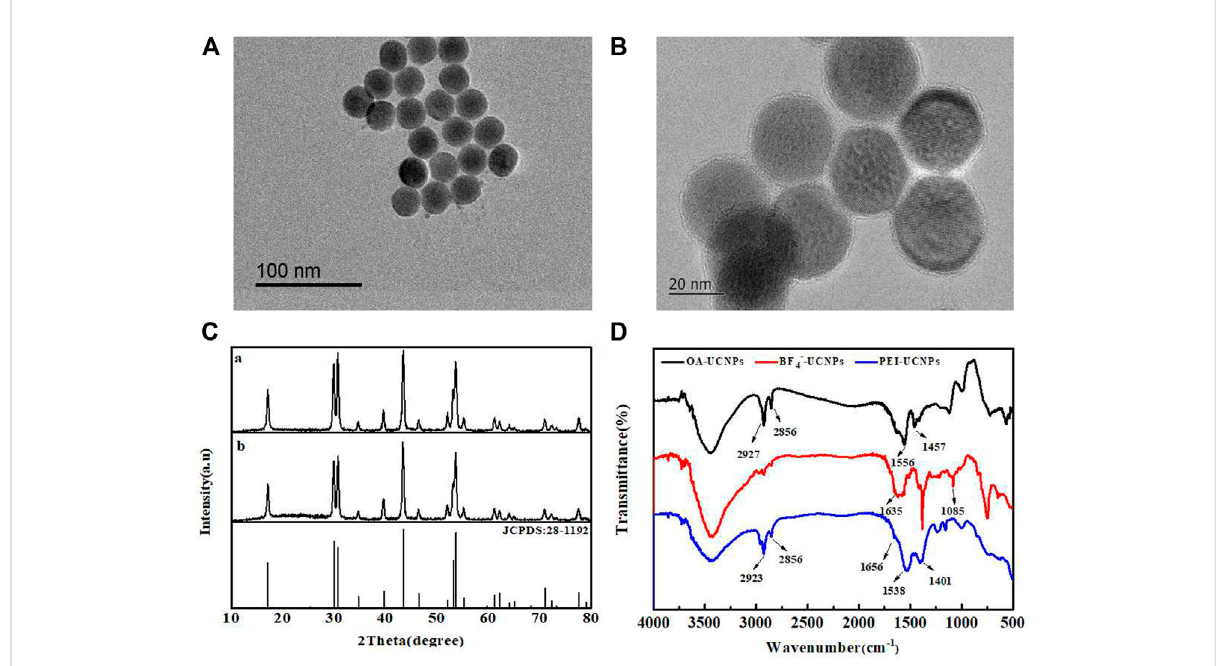
FIGURE 1 (A) TEMimageofOA-UCNPs. (B) TEMimageofPEI-UCNPs. (C) XRD patternsrecordedfor OA-UCNPs (a) andPEI-UCNPs (b) . (D) FT-IRspectra recorded for OA-UCNPs, BF 4 − -UCNPs and